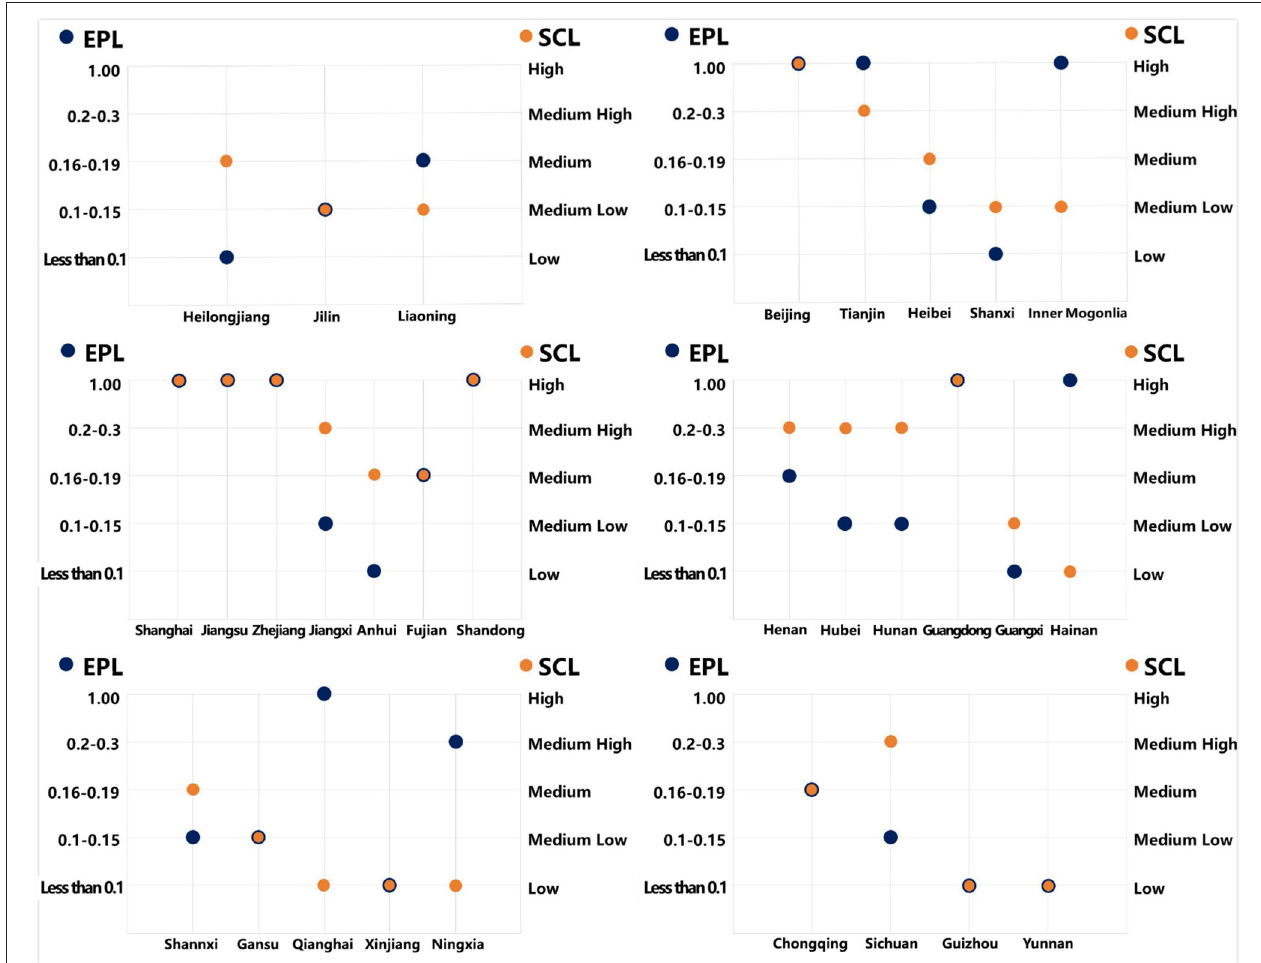
FIGURE 5 | Scatter plot of SCL and EPL in China in 2015.